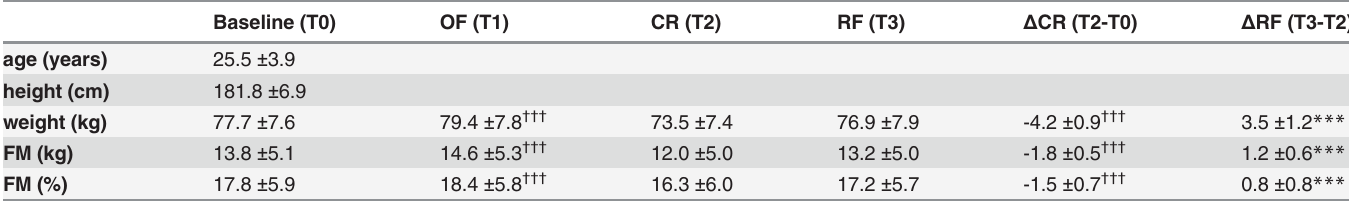
Table 1. Subject characteristics at baseline of the whole study population, and changes in body weight and fat mass during intervention periods, and changes of body weight and fat mass during CR and RF by intervention